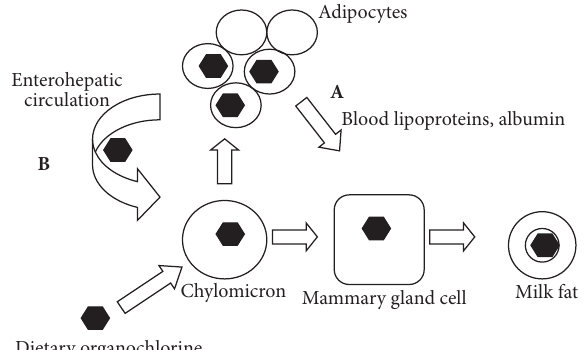
F 2: OC compounds (depicted by solid hexagons) are transported to mammary gland cells from adipose tissue carried by lipoproteins and albumin in blood (A). Chylomicrons also carry OCs from both the diet and enterohepatic circulation (B). Aim 1 addresses transport at